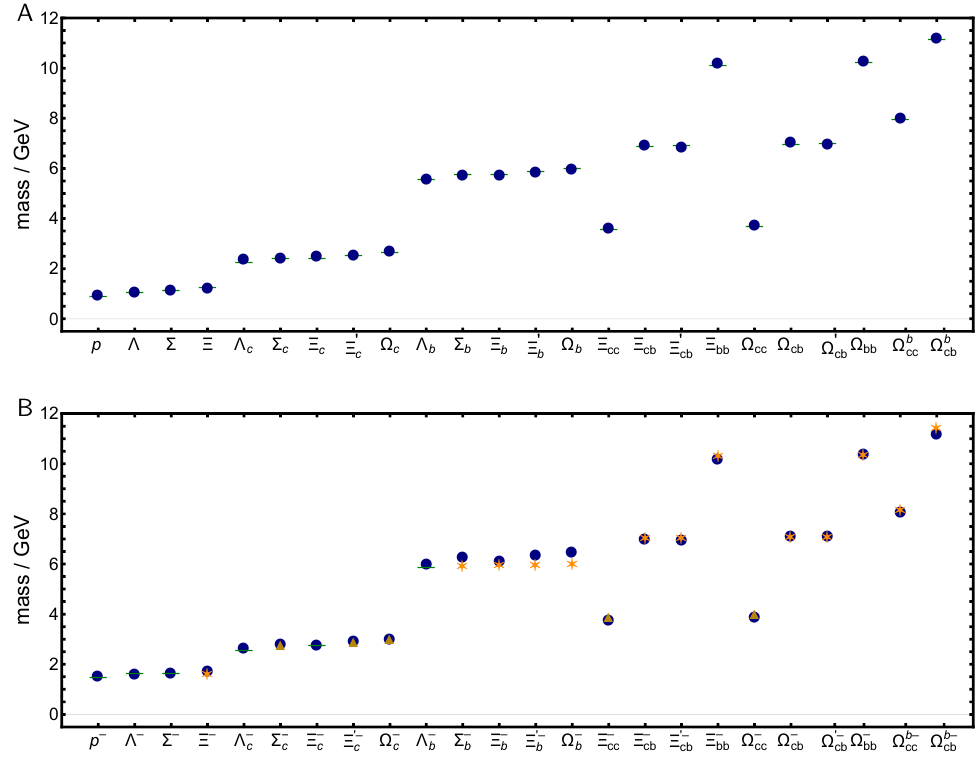
Figure 9. Upper panel ( A ): SCI-calculated masses of ground state flavour-SU ( 5 ) J P = 1/2 + baryons [232] compared with either experiment (first 15) [40] or lQCD (last 9) [262,263]. Lower panel ( B ): SCI masses of ground state flavour-SU ( 5 ) J P = 1/2 − baryons in [232] compared with ex- periment [40] (green bars), lQCD [264] (gold triangles), or three-body Faddeev equation results [218] (orange asterisks). Analogous plots for J P = 3/2 ± baryons are presented elsewhere ([232] (Figures 4B and